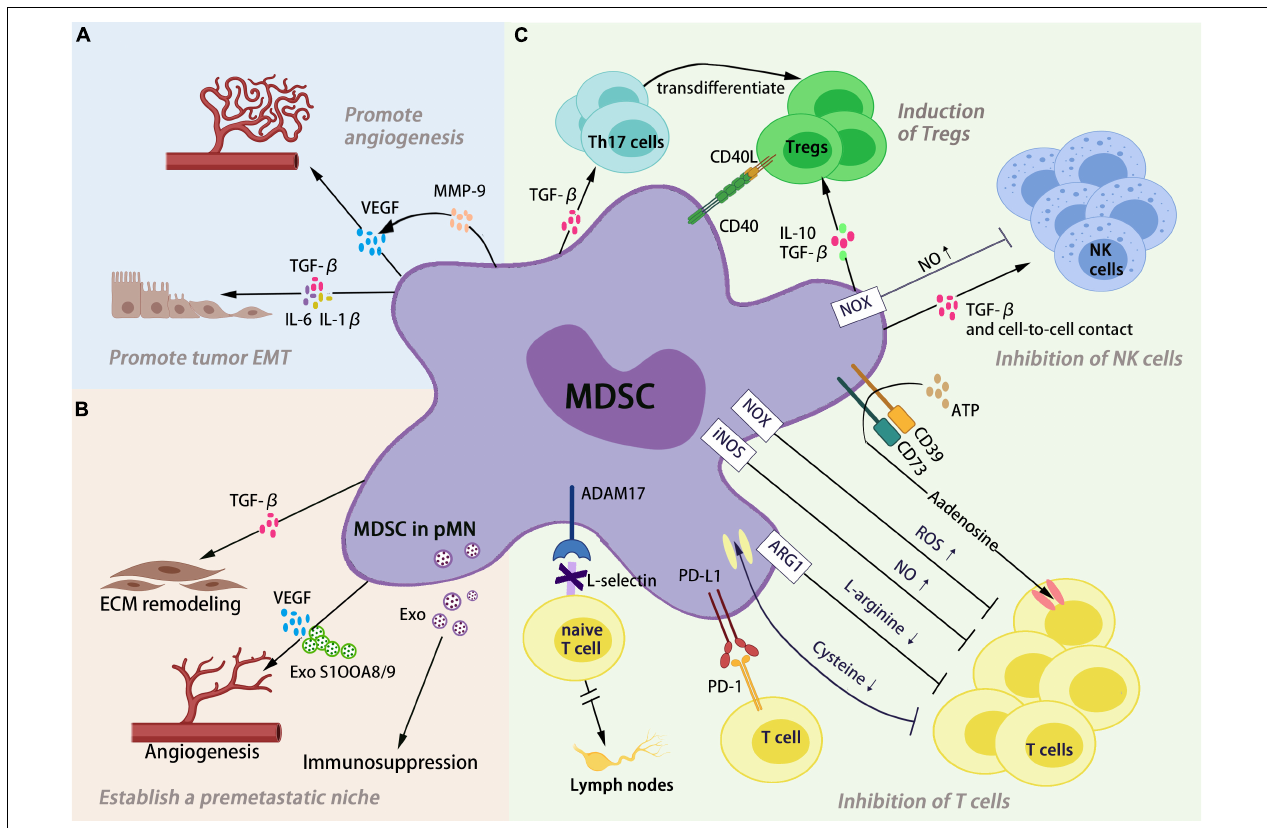
FIGURE 1 | Myeloid-derived suppressor cells (MDSCs) promote tumor development through different pathways. (A) MDSC non-immunologic functions. MDSCs in the TME promote tumor progression by promoting angiogenesis and EMT of tumors. (B) MDSC establish a pre-metastatic niche. MDSC-derived factors participate in the stepwise establishment of the PMN, resulting in a “soil” that supports the colonization of CTCs. (C) MDSC immunosuppression. MDSCs inhibit antitumor immunity by inhibiting T cells and natural killer cell proliferation and function and inducing Treg